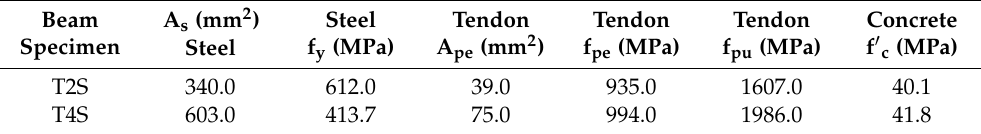
Table 2. Properties of the chosen beam specimens